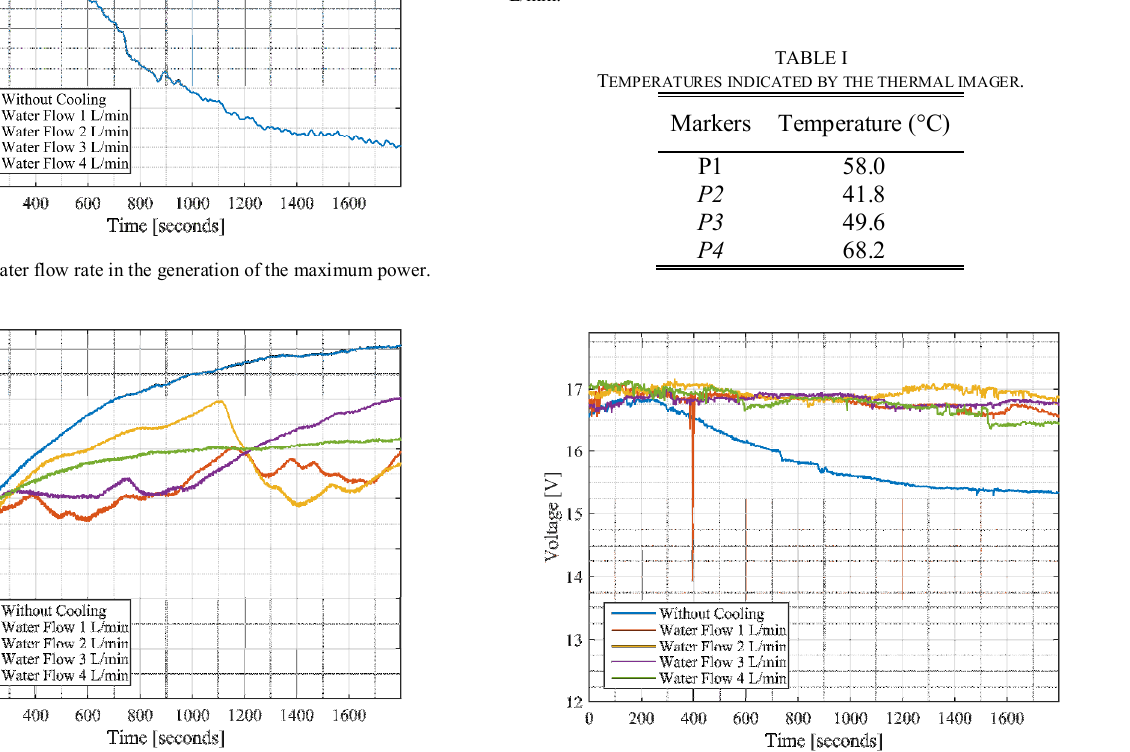
Fig. 7. Effect of water flow rate in the voltage